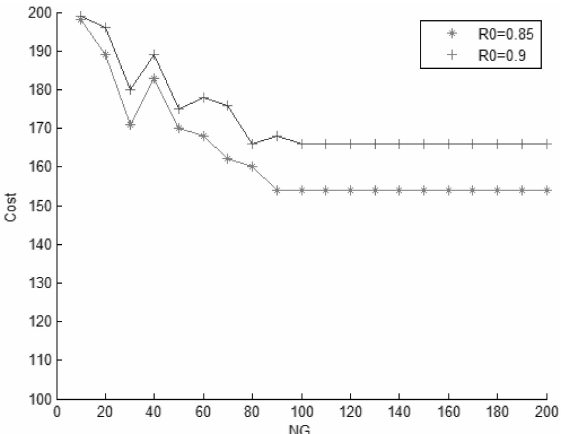
Figure 4. Effect of NG on Messy GA